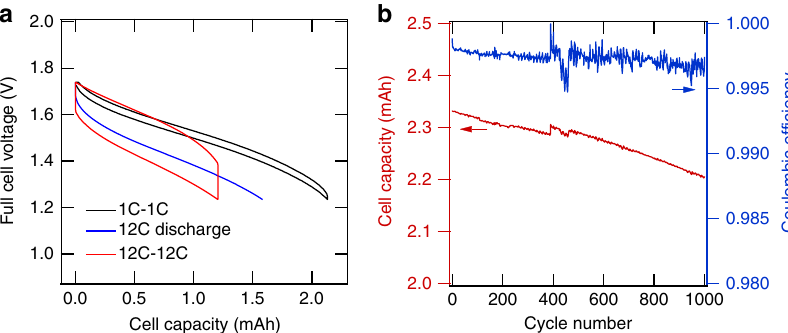
Fig. 6 Na-ion battery full-cell tests based on CuHCF cathode, MnHCMn anode, and co-solvent electrolyte. a The voltage pro fi les of the full CuHCF/ MnHCMn cell during 1C – 1C cycling, 12C discharge from 1.74 V, and 12C-12C cycling. The full-cell-speci fi c energy and energy density are 33 Wh kg – 1 and 66 Wh L – 1 , respectively. b The cycle life and coulombic ef fi ciency of the full cell during 1C – 1C cycling between 1.74 and 1.23 V. For the fi rst 400 cycles, galvanostatic charging with no potential hold (CV step) was used. After cycle 400, a CV step to a C/10 current, typically of 1 – 2 min in duration, was performed. The oscillations in capacity and coulombic ef fi ciency are diurnal and correspond to temperature fl uctuations from 23 to 25 °C in the cell